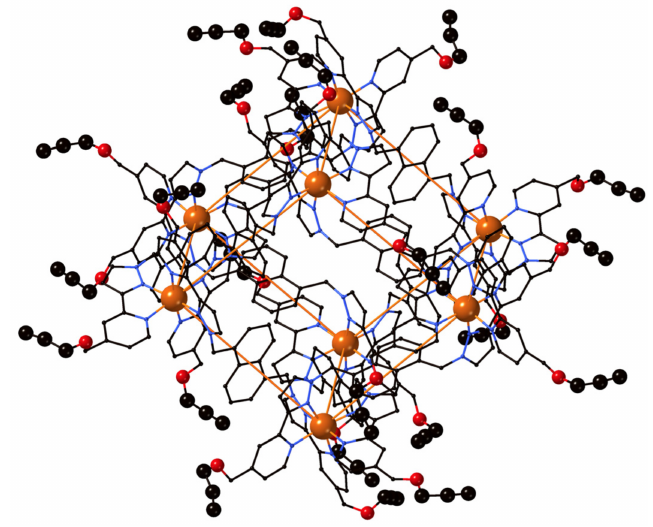
Figure 5. Crystal structure of the Ni(II) cage complex Ni • H CC . The core structure is the same as those shown in Figures 1 and 3, and is shown in wireframe; the pendant –OCH 2 –CCH groups are shown with their atoms as larger spheres (O, red; C, black) to emphasise the pseudo-spherical array of 24 externally-directed terminal alkyne